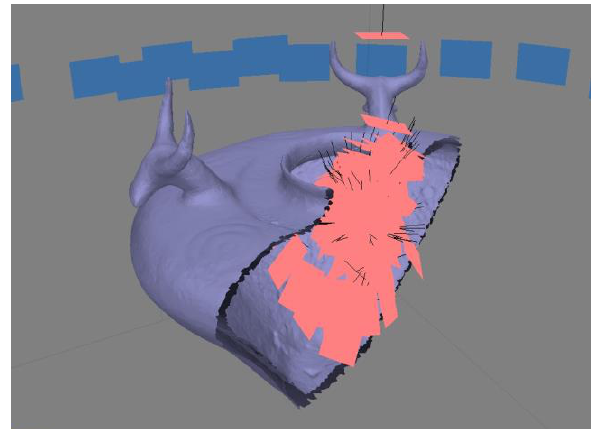
Figure 2: Aligned mobile phone images on the inside of the